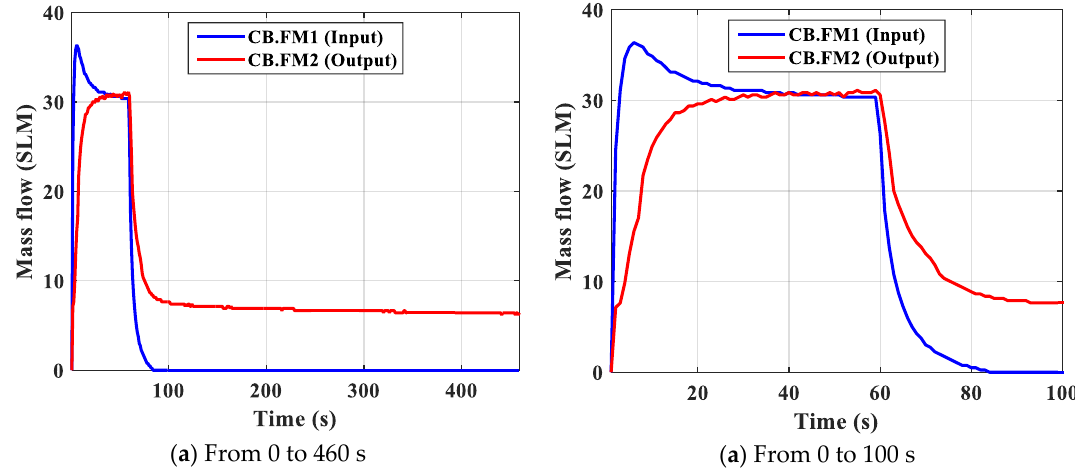
Figure 14. Mass flow input/output of a single fixed bed (see Figure 2).